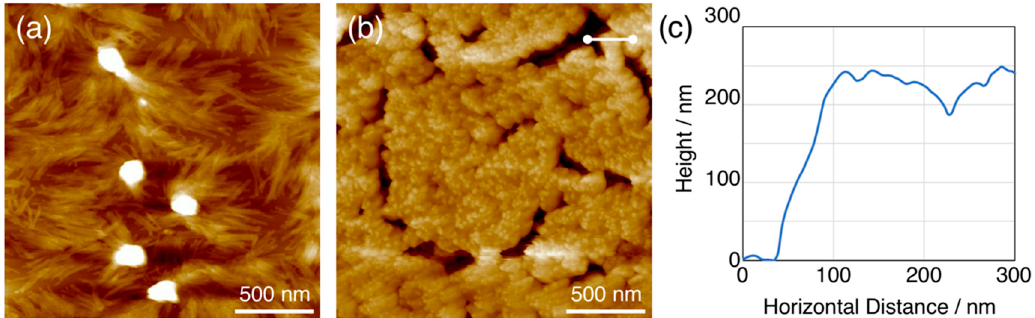
Figure 12. AFM images of nanowires from C 60 after 490 MeV 192 Os irradiation at 10 11 cm − 2 and subsequent ( a ) development with 1,2-dichlorobenzene or ( b ) sublimation. ( c ) Height profile along white line indicated in ( b ).